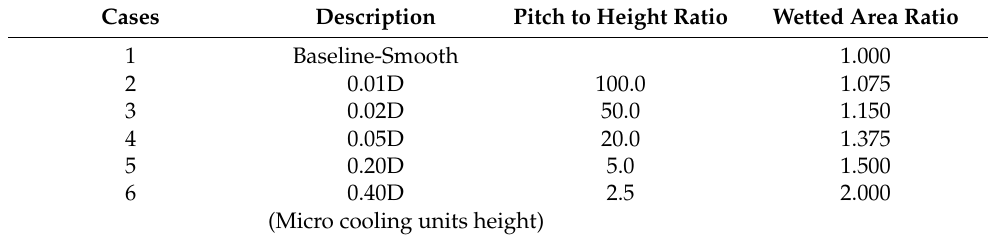
Figure 3. Copper bar with micro cooling units. Table 1. Target surface micro cooling units